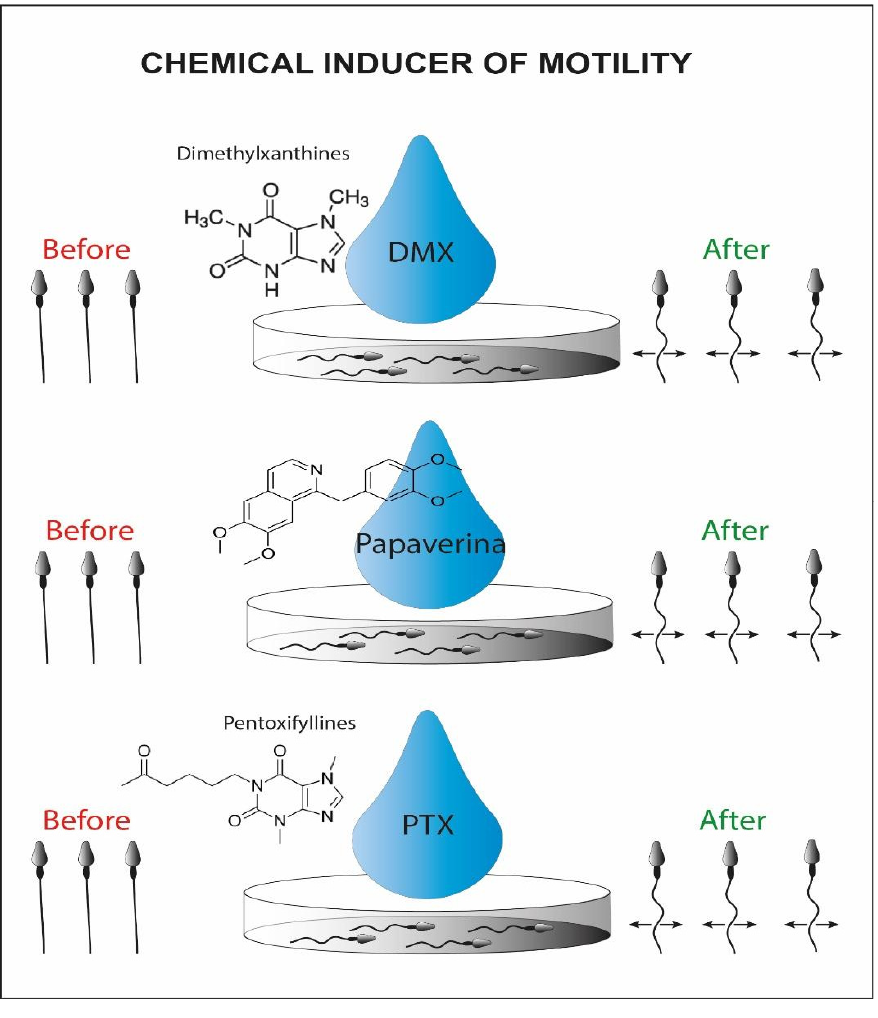
Figure 4. Schematic representation of chemical inducers of motility. On the left we can recognize the initial immotile sperms and on the right side the viable motile sperms activated by the chemical inducer.